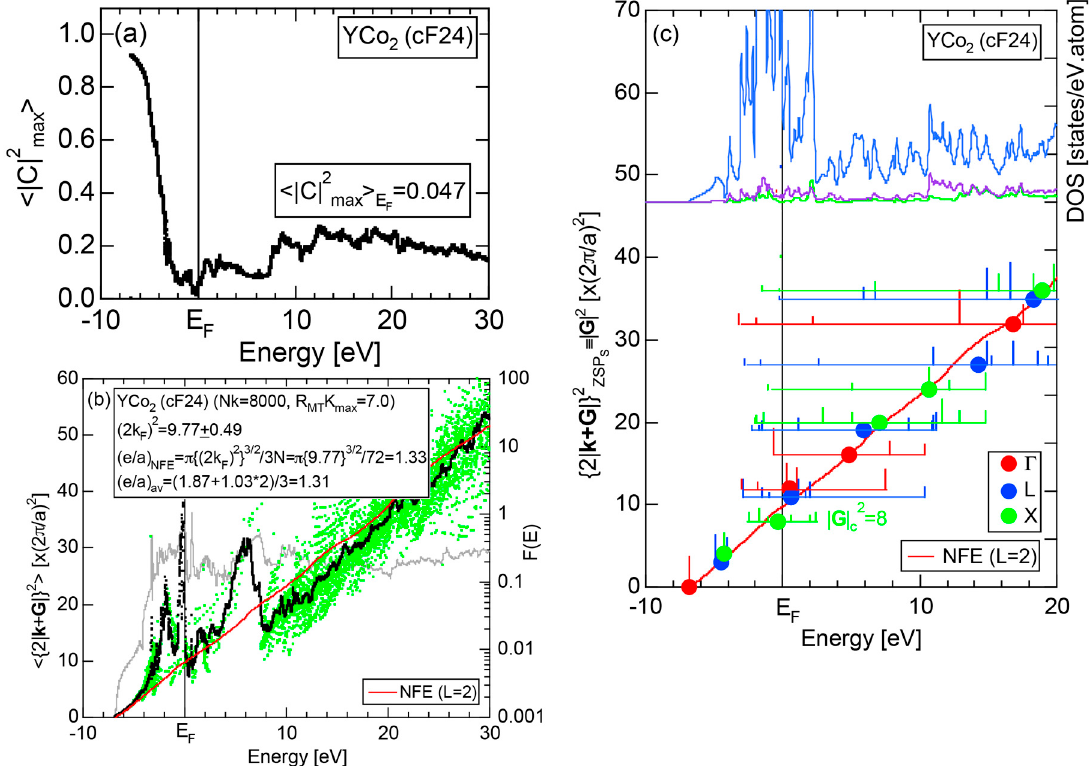
Figure 102. ( a ) | C | 2 , ( b ) Hume-Rothery plot and FLAPW-Fourier spectra for Laves compound YCo 2 (cF24). See captions to Figure 19 (b) for symbols in (c) [11,15,16,37]. Symbols in ( c ) refer to the total DOS (blue), Co-4p (purple) and Y-5p (green) partial DOSs and the center of gravity energy for G -specified plane wave spectra at (red circle), L (blue circle) and X (green circle) symmetry points of the fcc-Brillouin zone, the NFE ( L = 2) curve (red curve).